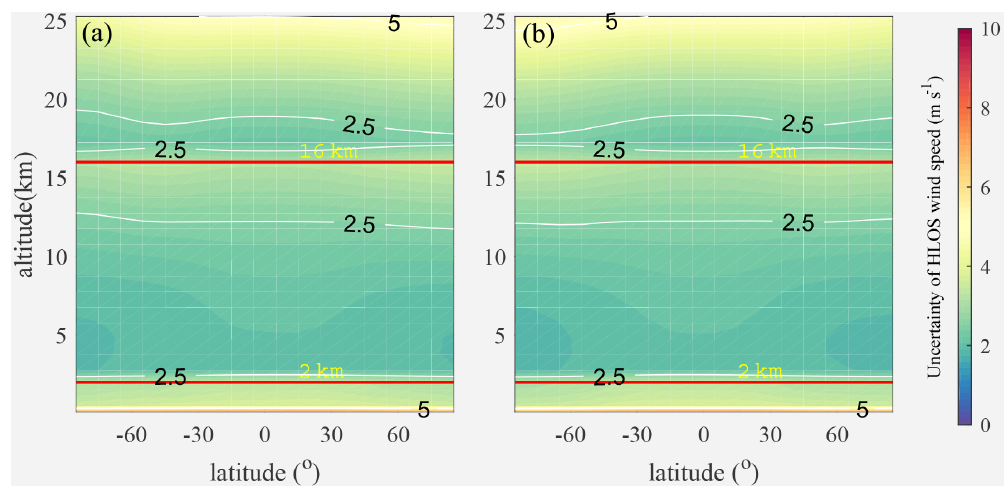
Figure 4. The latitude-averaged global distributions of the wind observation uncertainties without the impact of the SBR. (a) Summer; (b)